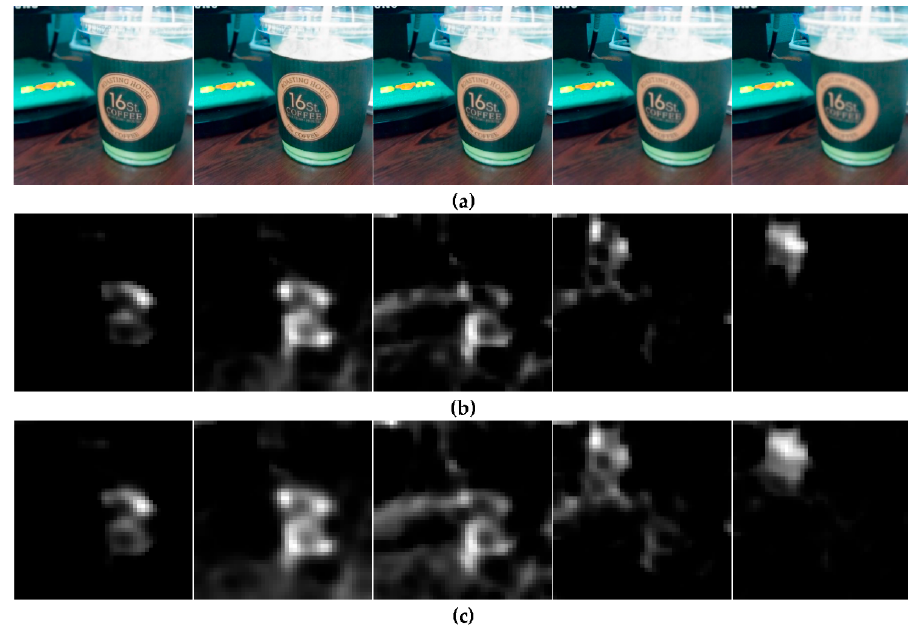
Figure 8. In-focused regions of the different focal stack images using SML and SUML: ‘Cup’ dataset; ( a ) The input images of different focal lengths; ( b ) SML of stack images; and ( c ) SUML of stack images.